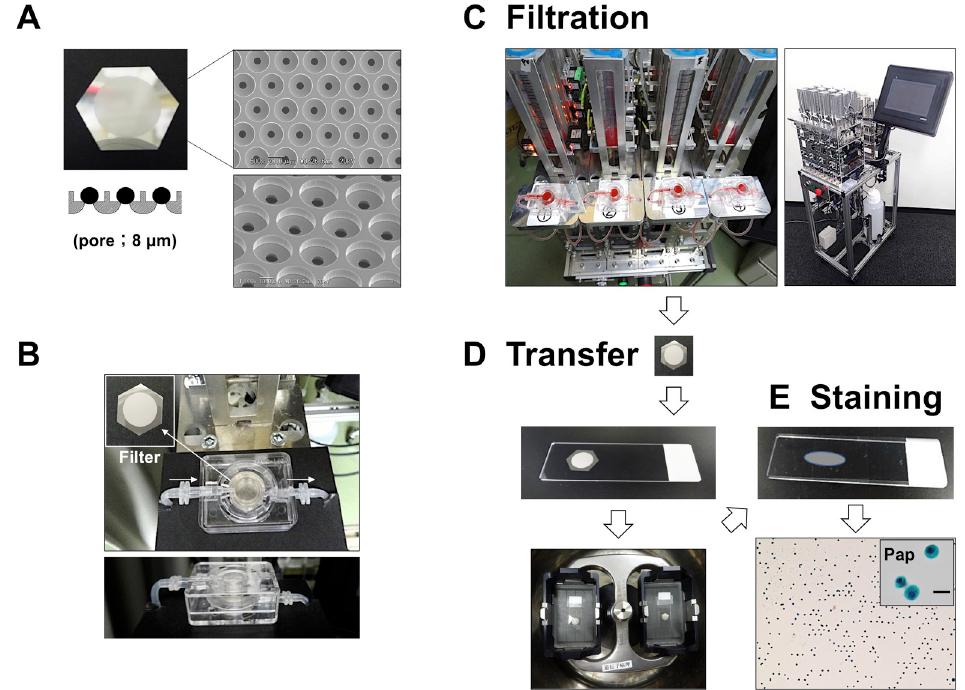
Fig 1. Flowchart of the CTC detection method using an automated cytology-based, microfluidic platform. ( A) Macroscopic view and scanning electron microscope image of the 3D metal (nickel) filter. (B) Overview of the disposable CTC filtration device containing a 3D filter inside. (C–E) Overview of sequential processes of CTC detection including filtration, CTC transfer to a glass slide, and staining. (C) Appearance of the multi (four)-channel automated CTC enrichment apparatus with a monitor panel. (D) Transfer of tumor cells (COLM-5) from the 3D filter to a glass slide by brief centrifugation. (E) Resultant transferred tumor cells on a glass slide after centrifugation visualized by Pap staining (right column). Inset: enlarged view of Pap-stained tumor cells. Bar = 20 μ m.